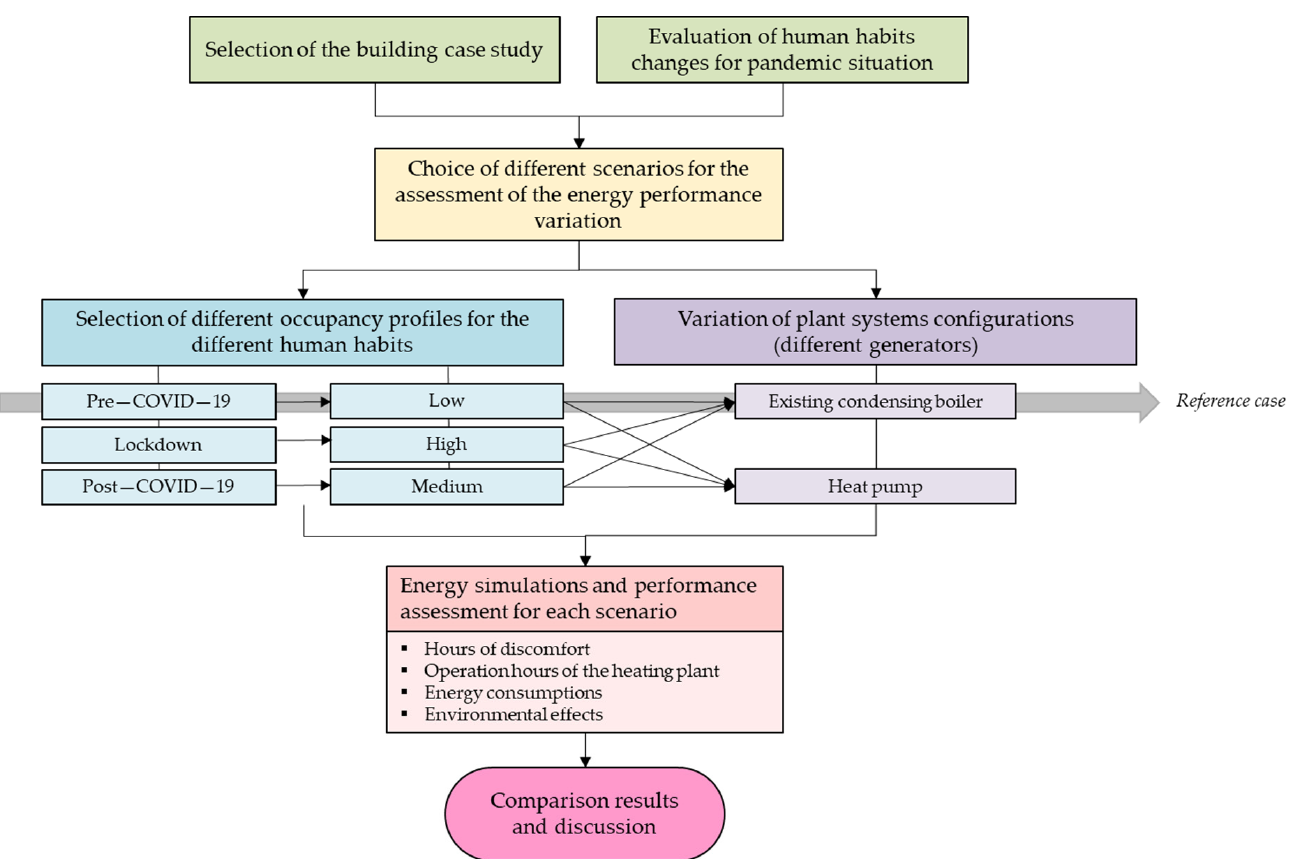
Figure 2. Methodology. Figure 2.